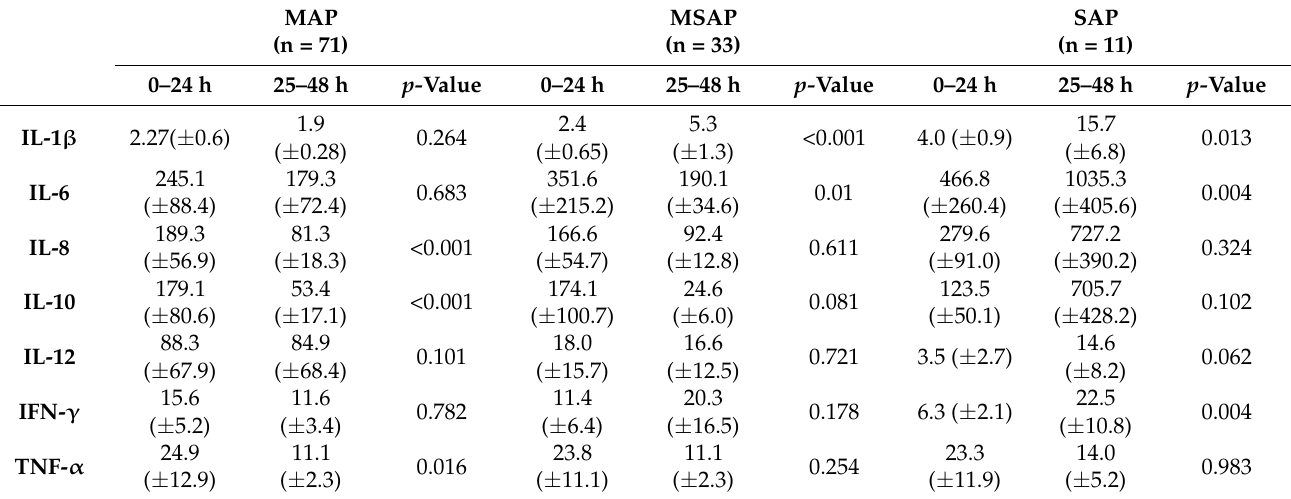
Table 2. Mean values of biomarkers at 0–24 and 25–48 h after onset of